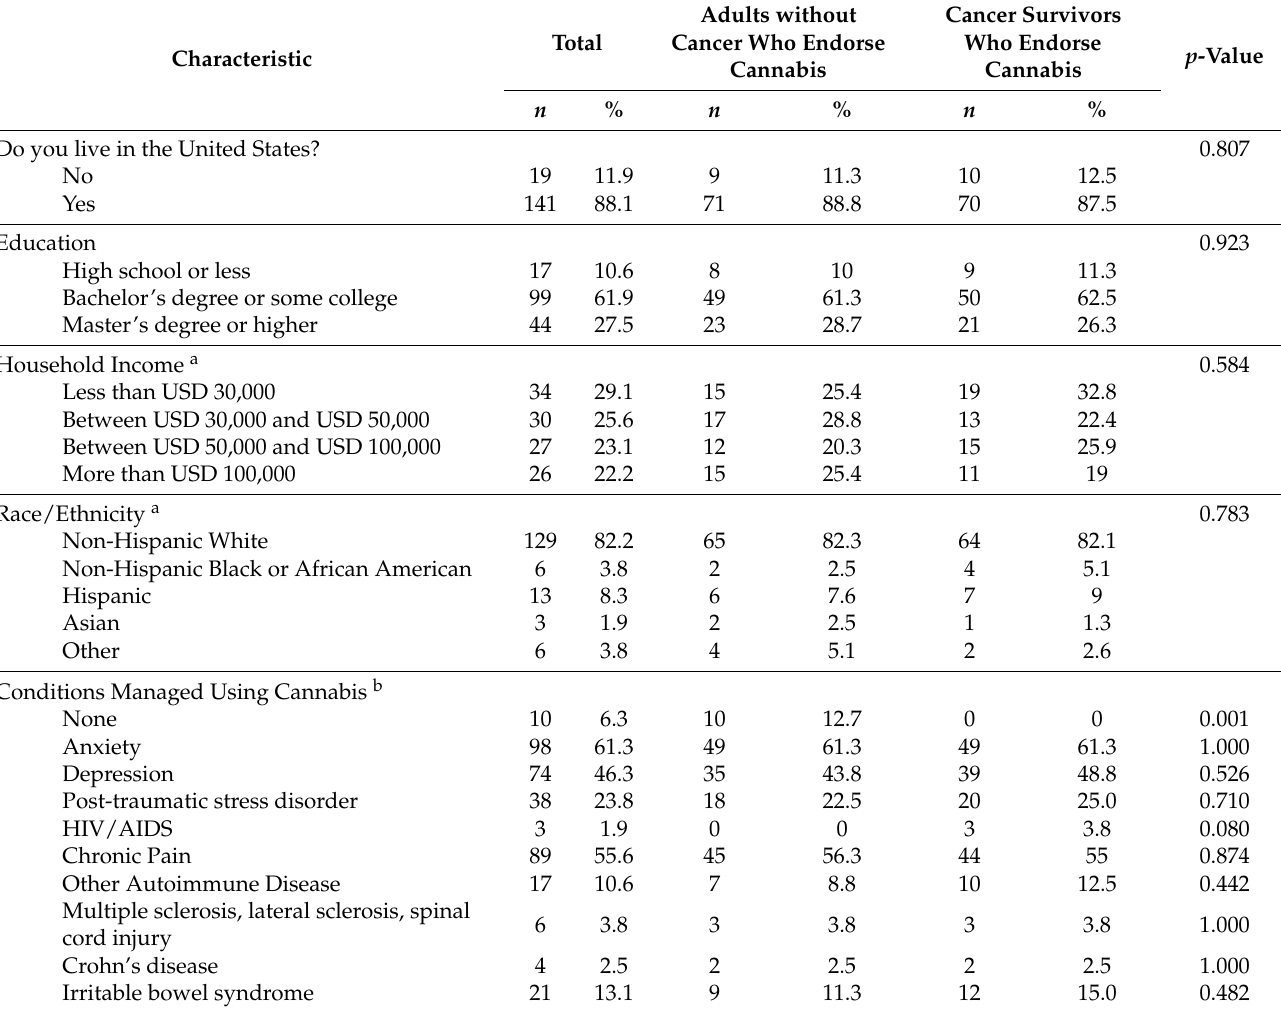
Table 1. Demographic characteristics of COVID-19 Cannabis Health Questionnaire